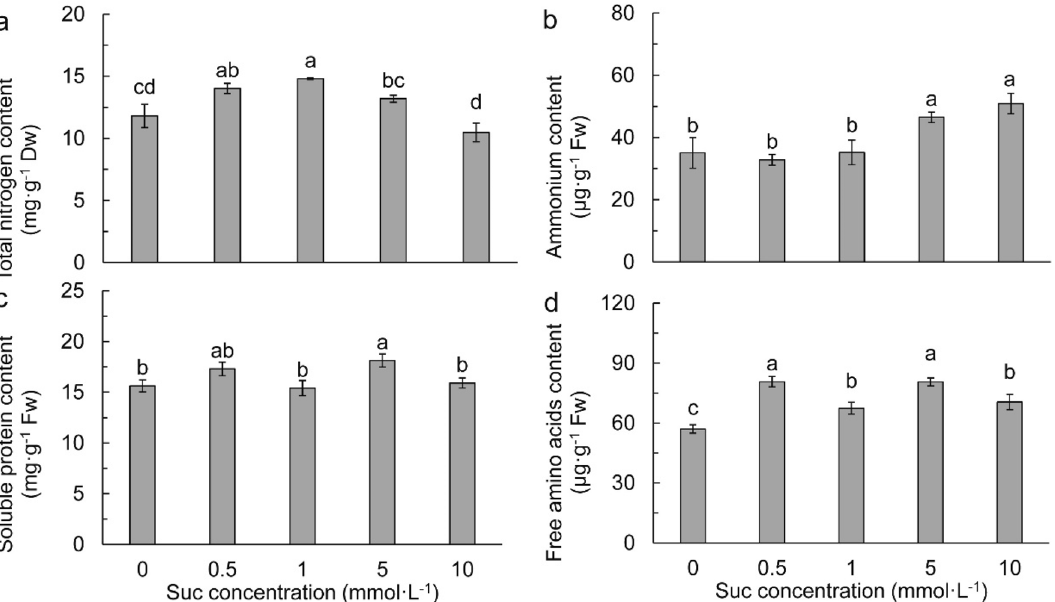
Figure 3. Leaf total nitrogen ( a ), ammonium ( b ), soluble protein ( c ), and free amino acids ( d ) in different sucrose concentrations. Data refers to means ± SE ( n = 4). Bars with the same letter are no statistically significantly difference at P < 0.05 by Duncan’s new multiple range